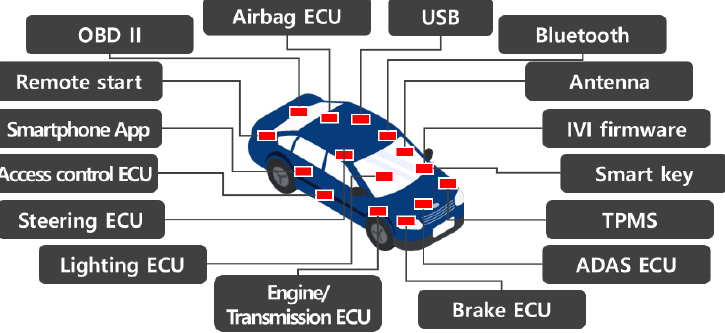
Figure 1. Connected car internal/external interfaces.